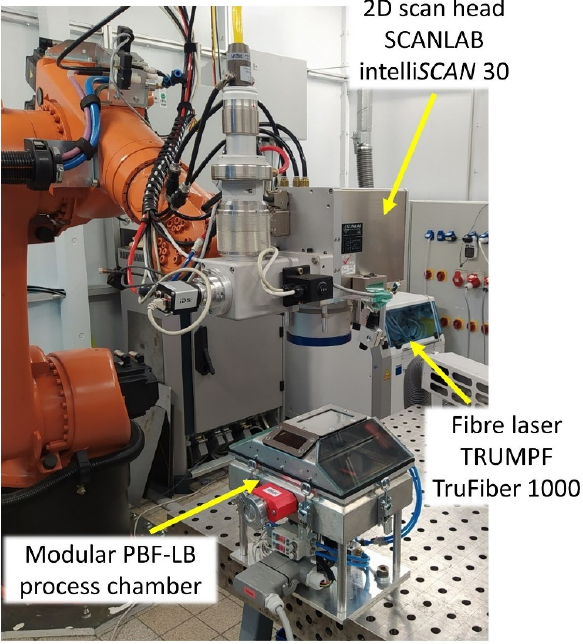
Figure 2. Experimental setup, including the custom ‐ made PBF ‐ LB chamber. Rectangular samples with a square cross ‐ section of 4 × 4 mm² were printed on an Ni ‐ base substrate plate (chemical composition given in Table 1), with a diameter of 40 mm and a thickness of 10 mm. The height of the fabricated samples differed within the parameter study due to the varying PBF-LB fabrication parameters. The laser power P L was varied between 200 W and 500 W in 100 W increments. In addition, the laser scan speed v S was varied between 500 mm/s and 800 mm/s in 100 mm/s increments, leading to a four ‐ by ‐ four array for the performed parameter study. All other parameters were kept constant throughout the PBF ‐ LB fabrication, with a hatch distance ℎ of 100 μ m (corresponding to the laser beam diameter on the powder ‐ bed surface) and no preheating of the substrate plate. Each layer was exposed, utilizing the bi ‐ directional line scanning strategy with a 90° rotation increment of the scan vectors between successive layers. Argon 5.0, with a purity of 99.999%, was used as shielding gas inside the process chamber before and during sam ‐ ple fabrication, and the residual oxygen content was kept below 50 ppm at all times. It should be noted that the mechanically alloyed CrFeNiTi MPEA powder did not fulfil the powder quality criteria defined by Spierings and Levy [23] and Karapatis et al. [24], and the comparatively coarse feedstock necessitated a thicker than usual powder layer thick ‐ ness 𝑡 of 100 μ m.